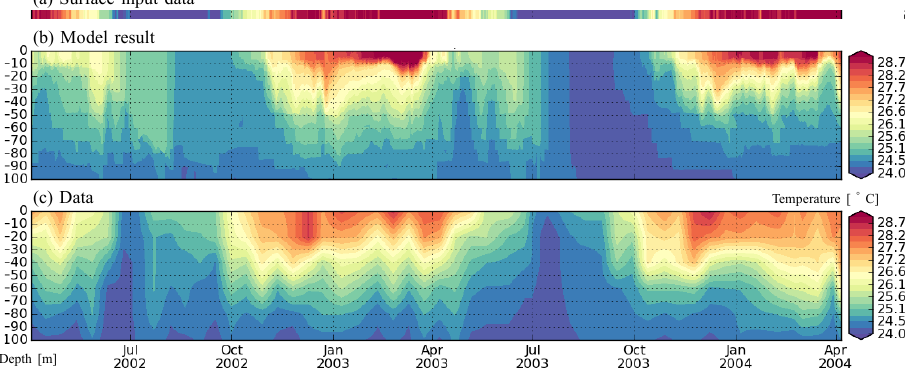
Figure 15. Lake water temperature ( ◦ C) at Mpulungu as predicted by the model (b) and from in situ observations ( c , Descy et al., 2006). Panel (a) shows the surface temperature used to force the temperature flux at the lake surface (Thiery et al., 2015).